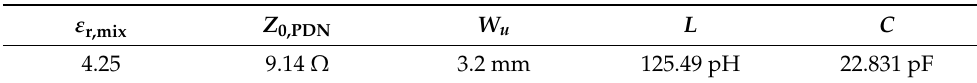
Table 1. Summary of important design parameters and values used to derive dispersion diagrams shown in Figure